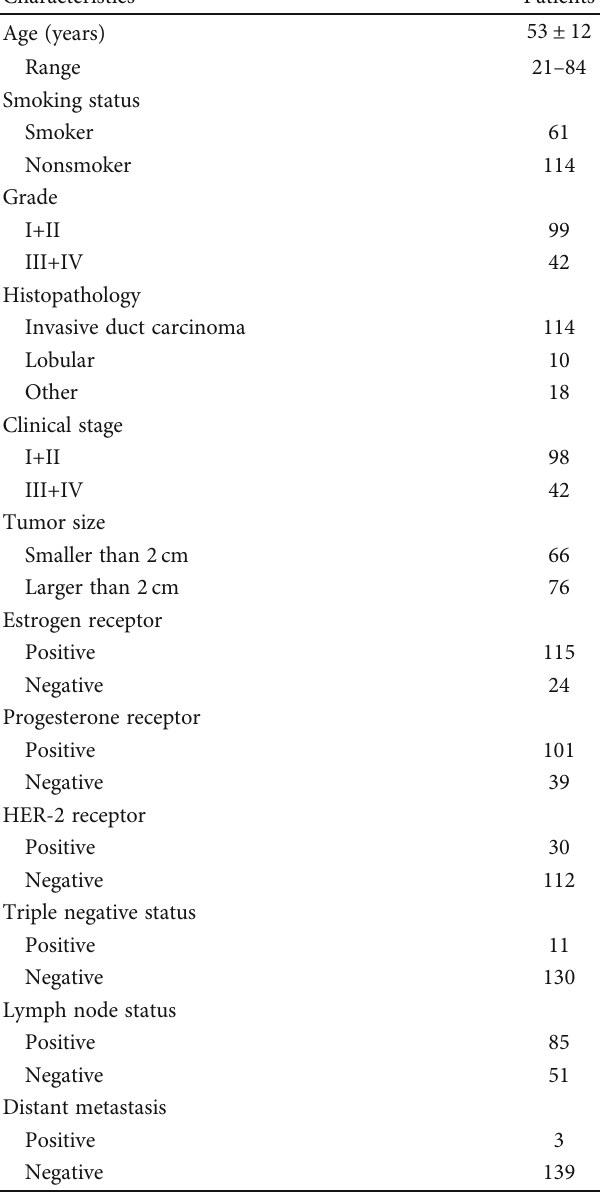
Table 1: Distribution of clinical characteristics of the